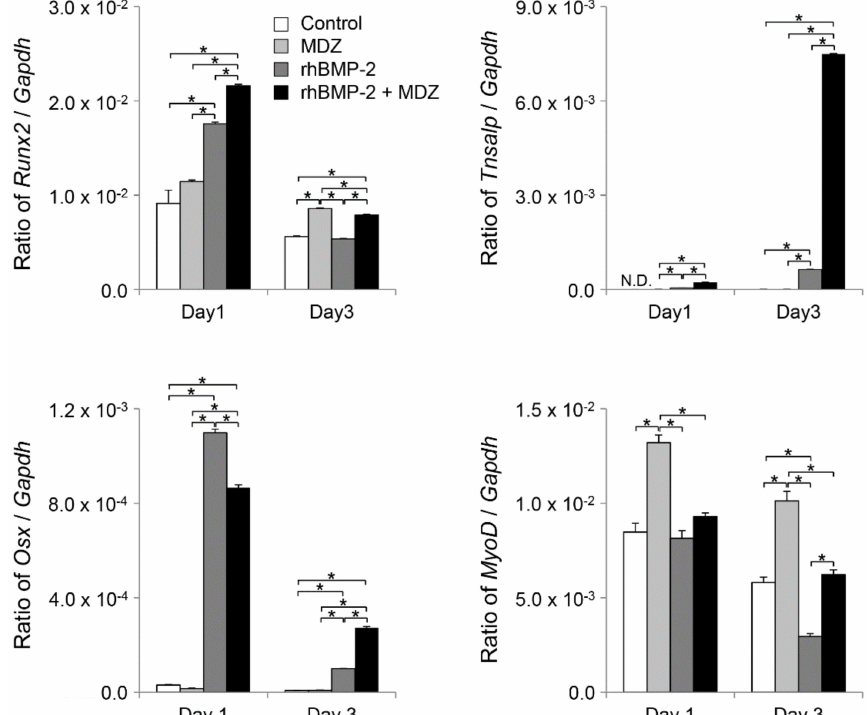
Figure 4. Combined e ff ect of MDZ and BMP-2 on gene expression in the C2C12 cells. qPCR analysis on days 1 and 3 after culture in the absence (Control) or presence of MDZ alone (MDZ), rhBMP-2 alone (rhBMP-2), and the combination of rhBMP-2 and MDZ (rhBMP-2 + MDZ). Runx2 , runt-related transcription factor 2; Osx , osterix; Tnsalp , alkaline phosphatase; MyoD , myoblast determination protein 1; ND, not determined. Each mRNA expression value was normalized to that of the reference gene glyceraldehyde-3-phosphate dehydrogenase ( Gapdh ), and the relative quantification data for Runx2 , Osx , Tnsalp , and MyoD in C2C12 cells were generated on the basis of a mathematical model for relative quantification in a qPCR system ( n = 6). All values are presented as the mean ± SEM (* p < 0.05, Steel–Dwass